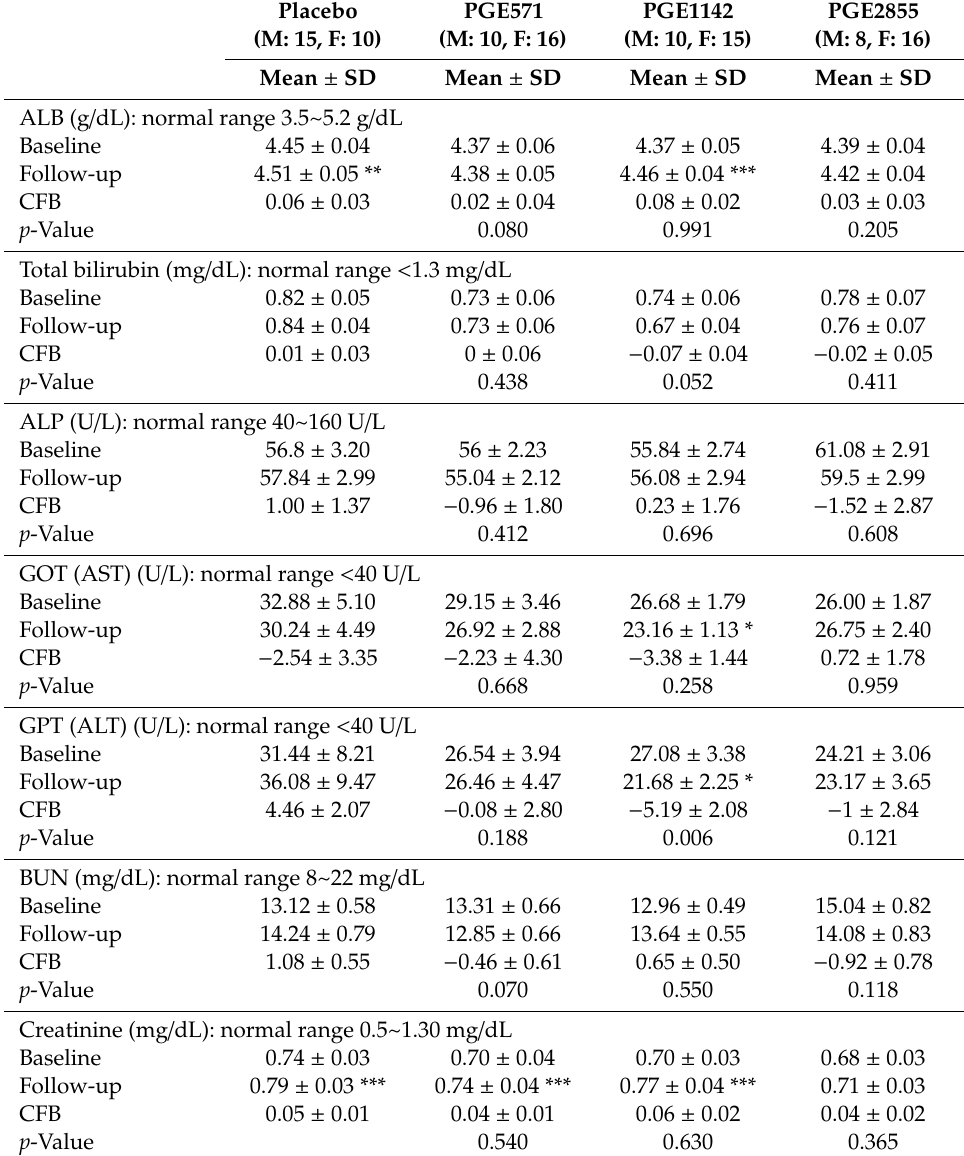
Table 8. Effect of PGE supplementation for 12 weeks on plasma albumin, total bilirubin, alanine aminotransferase (ALP), glutamic oxalacetic transaminase (GOT), glutamic pyruvate transaminase (GPT), blood urea nitrogen (BUN), and creatinine levels in subjects with overweight or obesity ( n =